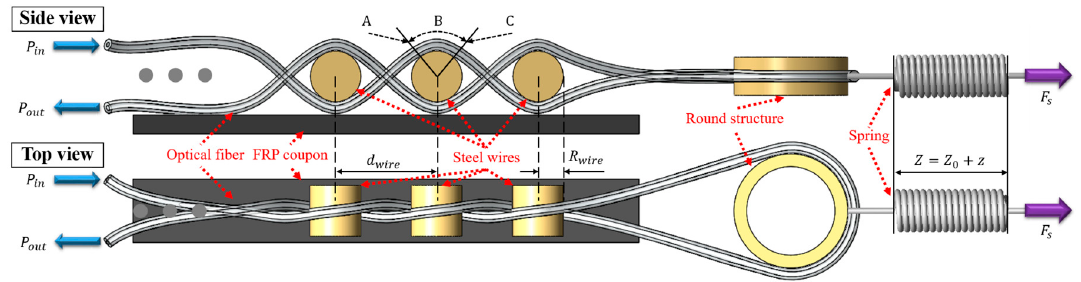
Figure 1. Schematic of the experimental setup for measuring the twisted dual-cycle bending loss characteristics ( d wire : distance between steel wires; R wire : steel wire radius; Z : length of spring; Z 0 : free length of spring; z : spring deflection length; F s : spring tension